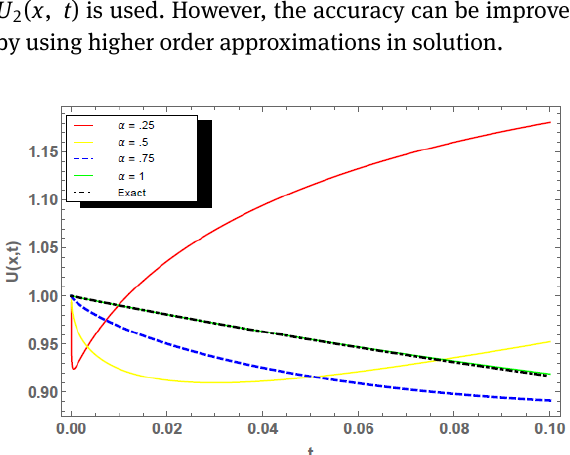
Fig. 8: Plots of U ( x , t ) vs . t at α = 0.25, 0.5, 0.75 and α = 1 at λ = 1 for exact solution and approximate solution for Eqs.